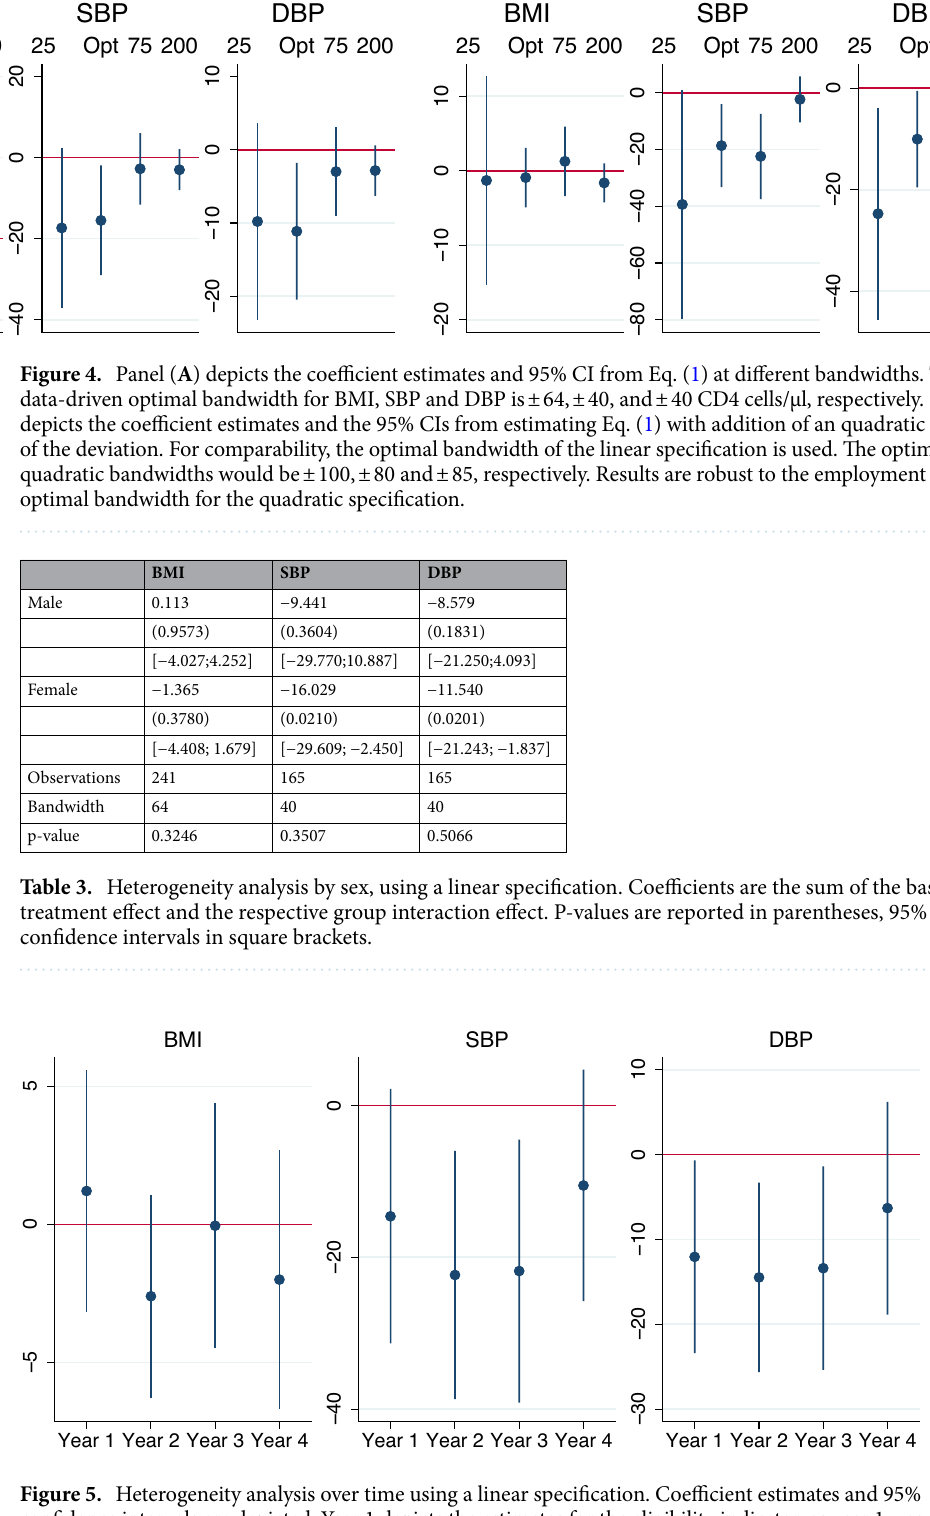
Figure 5. Heterogeneity analysis over time using a linear specification. Coefficient estimates and 95% confidence intervals are depicted. Year 1 depicts the estimates for the eligibility indicator, as year 1 was used as the base level in the regression. Years 2–4 depict the estimates of a linear combination of the base treatment effect plus the interaction effect with the respective